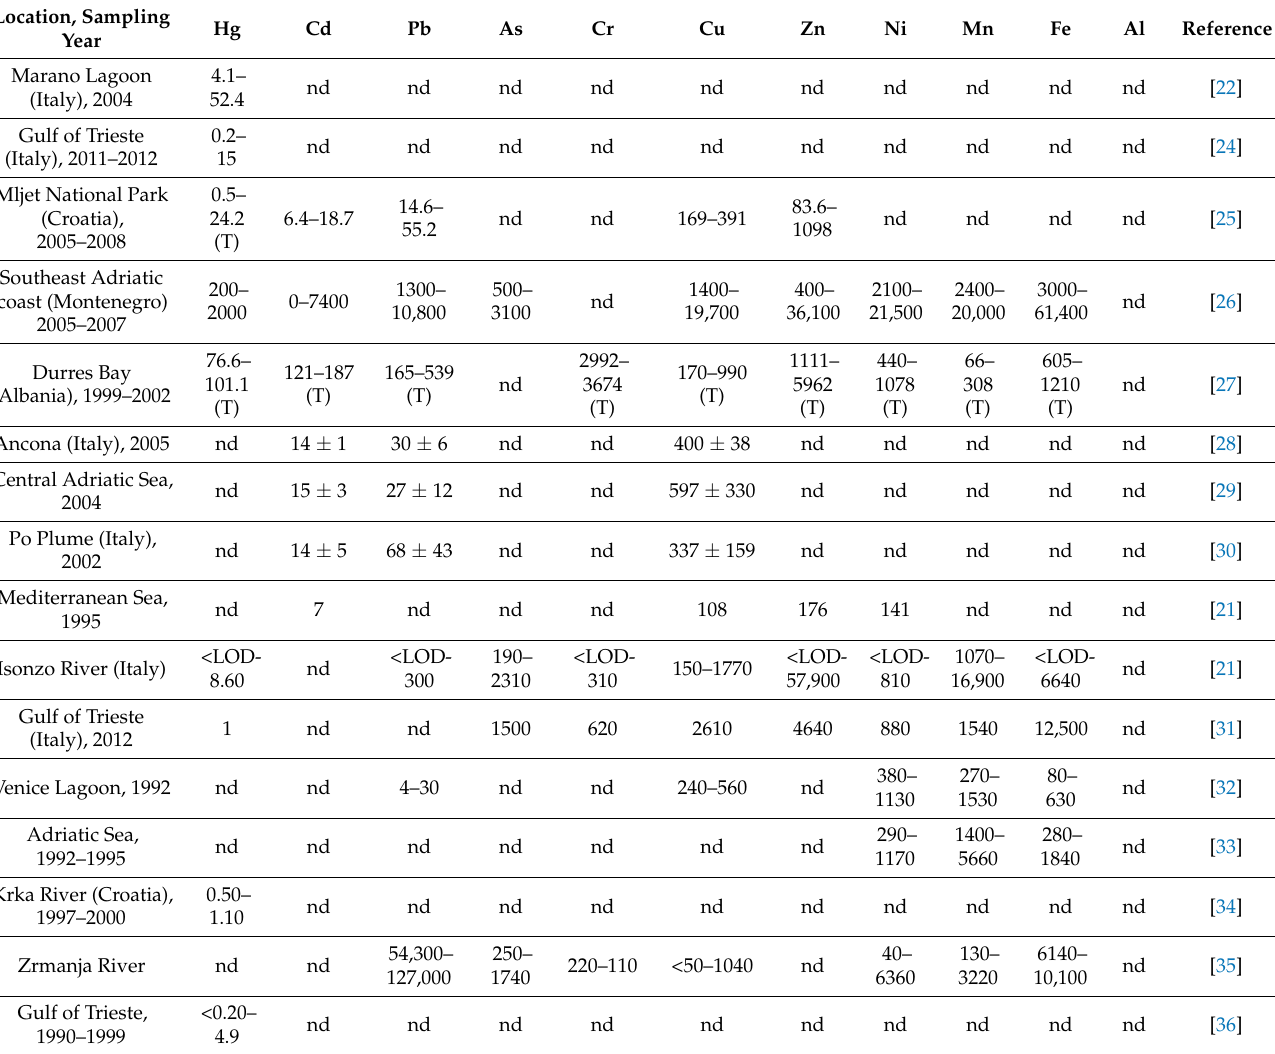
Table 3. Dissolved metals levels in seawater (ng L − 1 ) from literature. Data are expressed as mean ± sd (min-max) (T: total concentration; nd: not